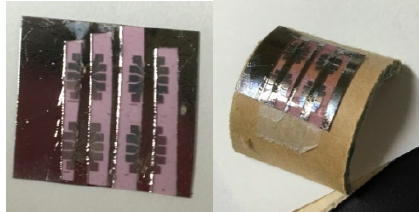
Figure 7. Photographic images of the flexible SBS film loaded with the P3HT nanofibers ( left ), and the film bent along the cylindrical mold with a radius of curvature of 1.75 cm ( right ).